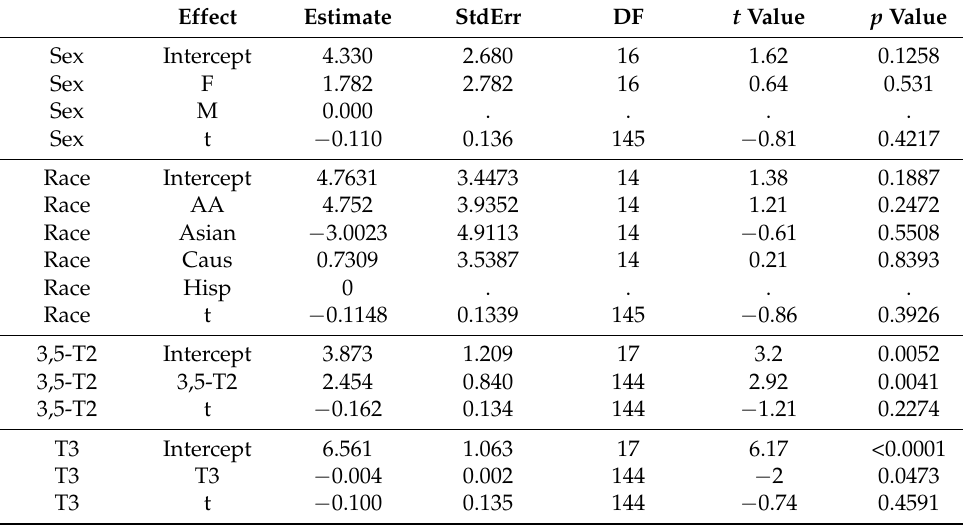
Table A6. Analysis of 3-T1AM levels: Participants with hypothyroidism,